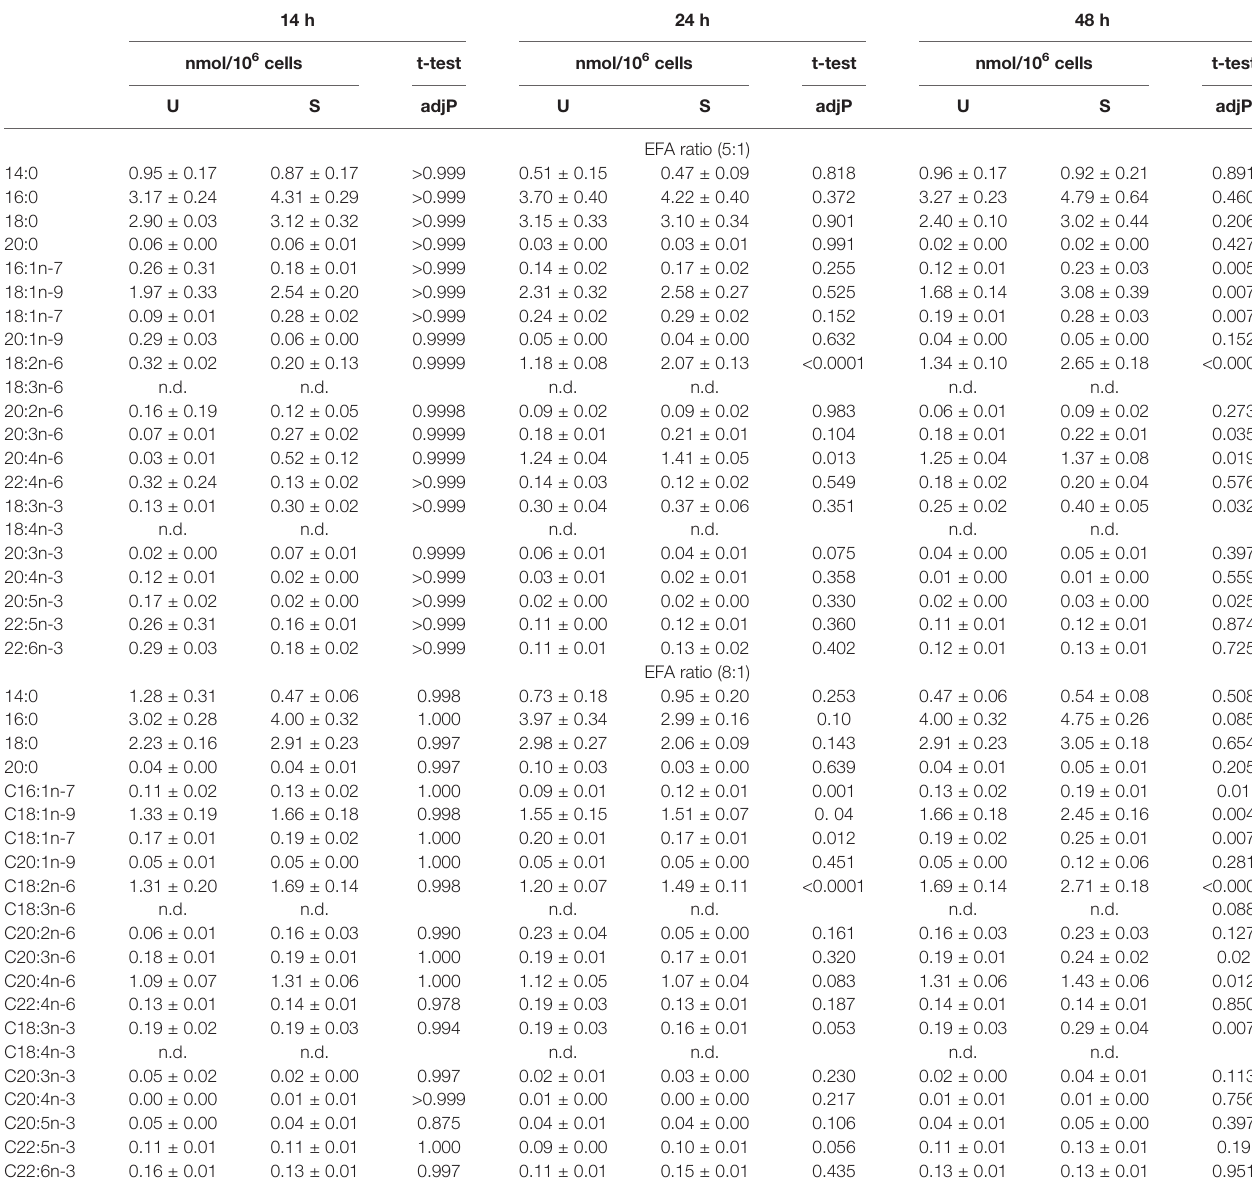
TABLE 2 | The effect of mitogen stimulation on T-cell total fatty acid composition.